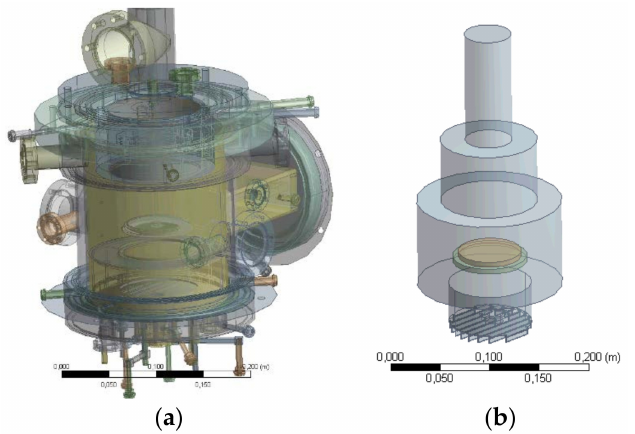
Figure 2. HP MOVPE (High-Pressure Metal-Organic Vapor Phase Epitaxy) reactor: ( a ) detailed geometry, ( b ) simplified 3D